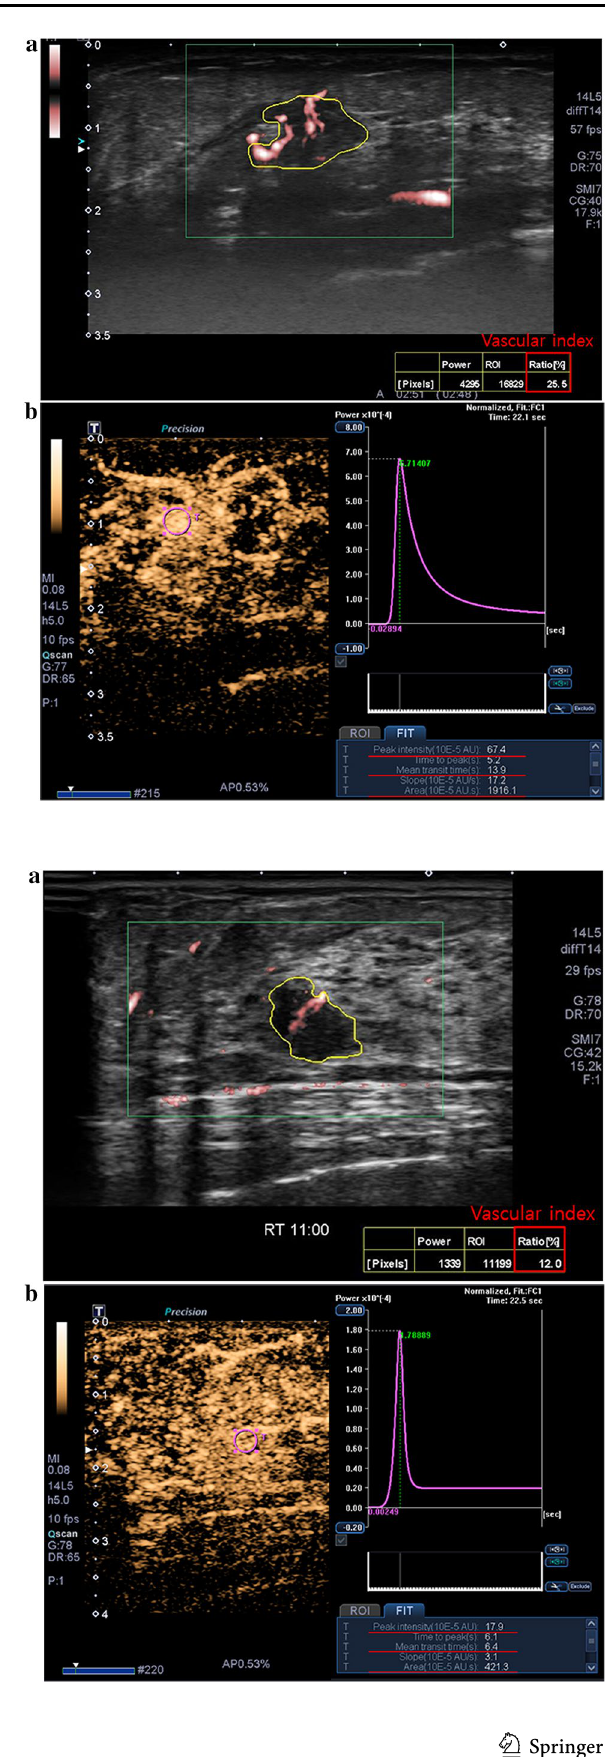
Fig. 2 A 53-year-old female with invasive ductal carci- noma. a A microvascular US image shows an increased vascular index, 25.6% (above the mean value of 16.1%) (red box). b A contrast-enhanced US image shows high peak intensity, 67.4 × 10 −5 AU (above the mean value of 34.2 × 10 −5 AU), and area under the curve, 1916.1 × 10 −5 AU·s (above the mean value of 890.0 × 10 −5 AU·s), and low mean transit time, 13.9 s (below the mean value of 14.4 s). DNA sequenc- ing results for the cancer showed the presence of SNP rs1136201 in ERBB2 gene, SNP rs2305948 in KDR gene, and SNP rs35597368 in PDGFRA